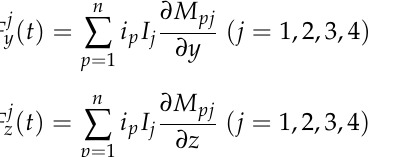
( t ) = F i ( t ) = F i ( t ) ). z_left z z_left z_right z_left